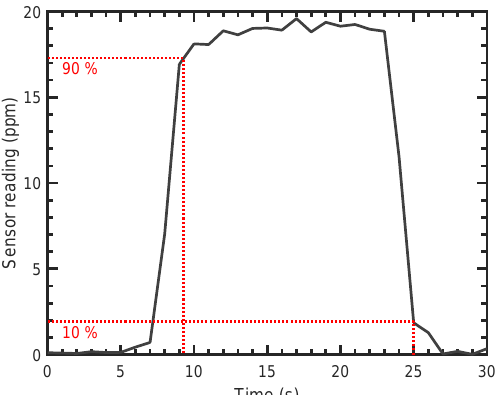
Figure 9. Sensor step response for a step from zero air to a concentration of 19.2ppm NO 2 and back at 0.5slpm and 1s integration time. Response time to 90% ( τ 90 ) and recovery time to 10% ( τ 10 ) signal level are below 3s and 2s,